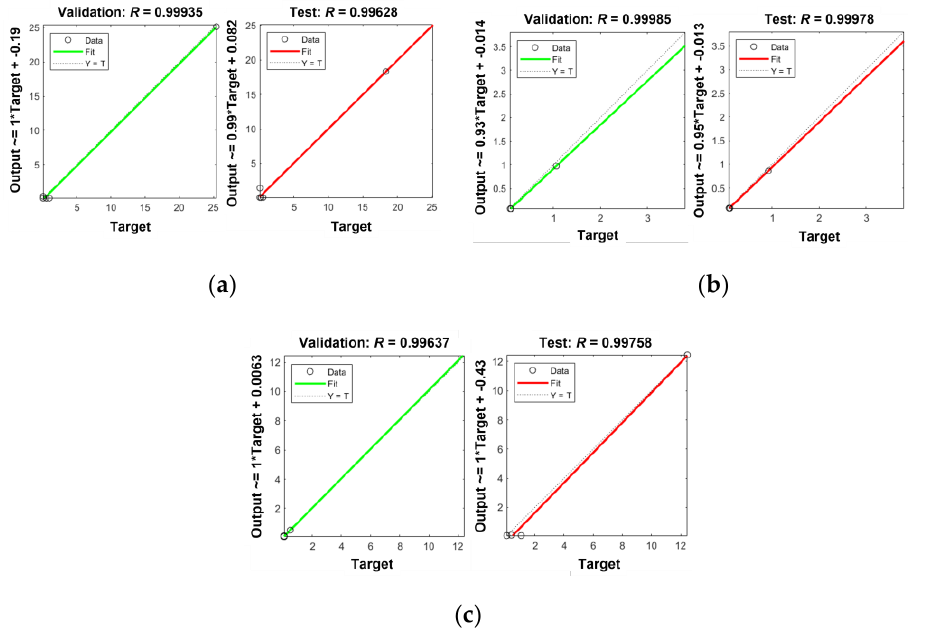
Figure A10. Correlation plots for NN-PSO simulations of HI (children) for ( a ) TW, ( b ) GW, and ( c ) WRS.